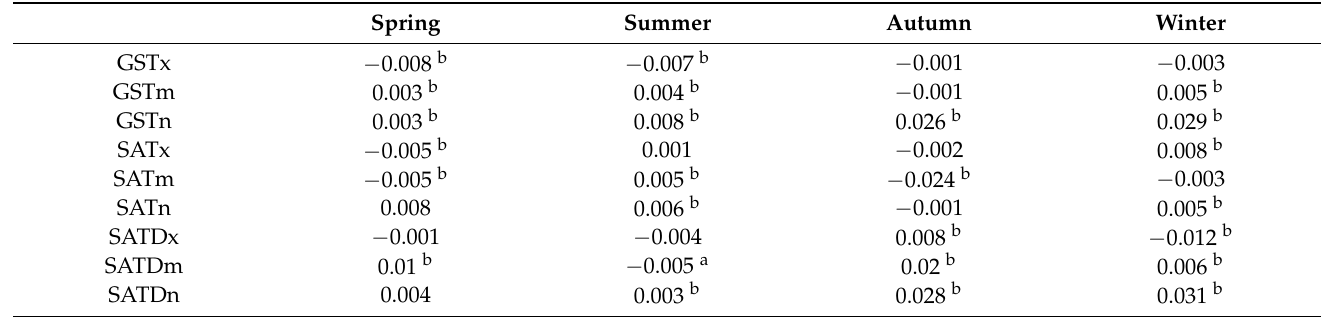
Table 7. The slope ( ◦ C/(year · km)) of variation rate of seasonal averaged GST-, SAT-, and SATD- related indexes from 1980 to 2019 with elevation from 64 to 6304 m in Southwest China. Spring